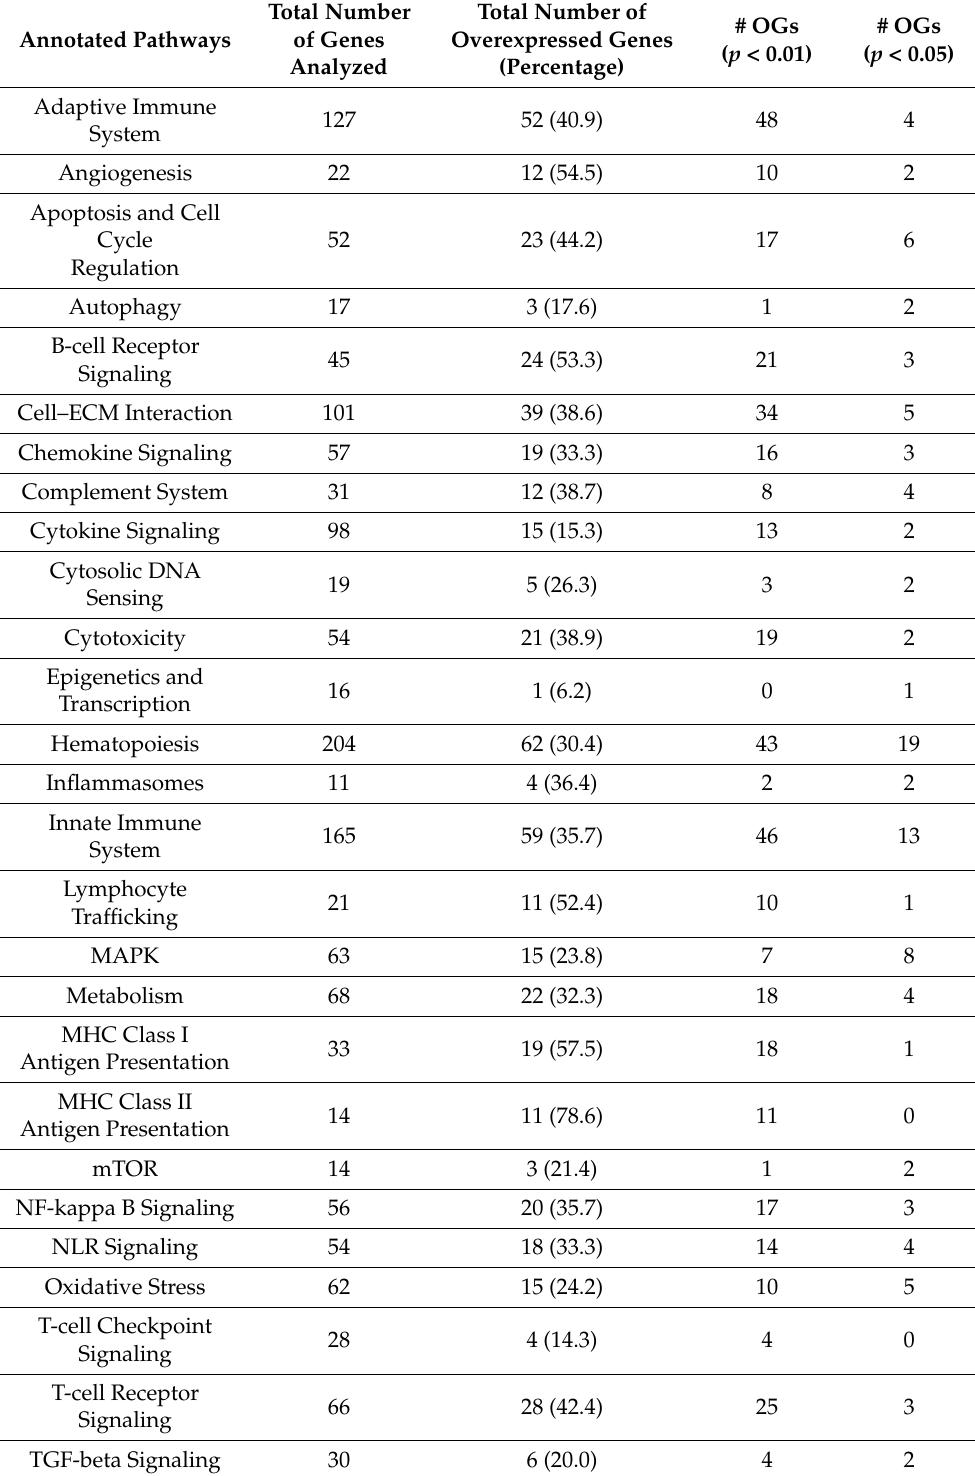
Table 6. Overexpressed genes (OGs) in c-ABMR compared with control samples according to nCounter ® Human Organ Transplant annotated